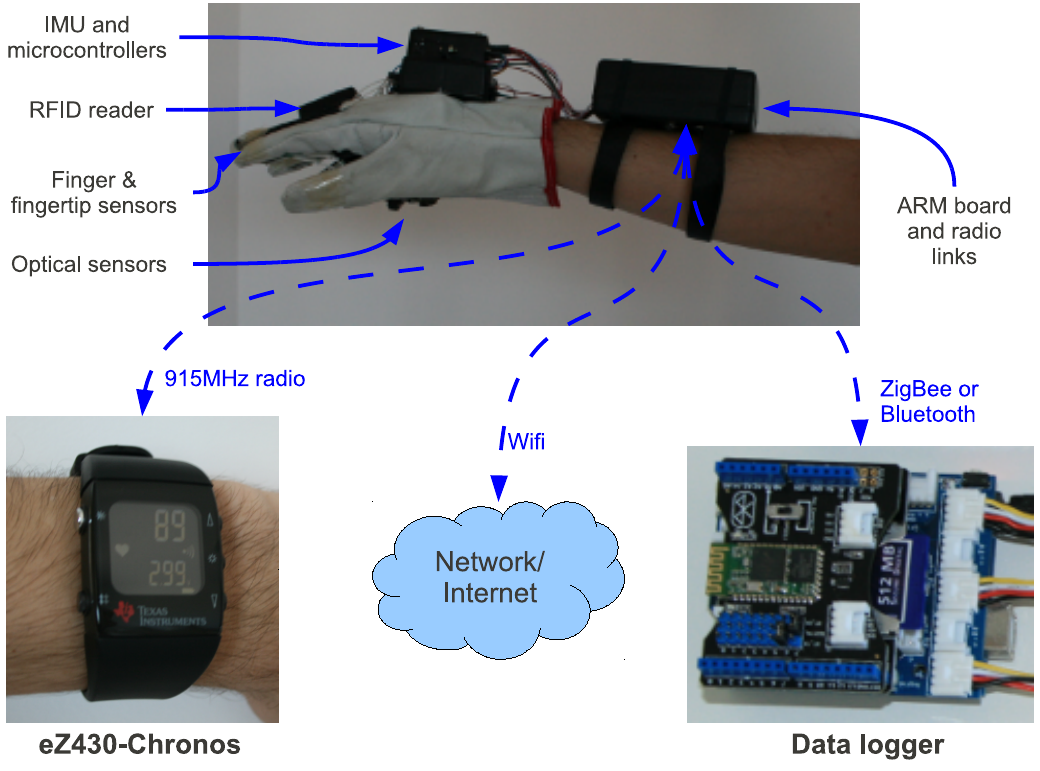
Figure 1. Overview of the system and its communication with external